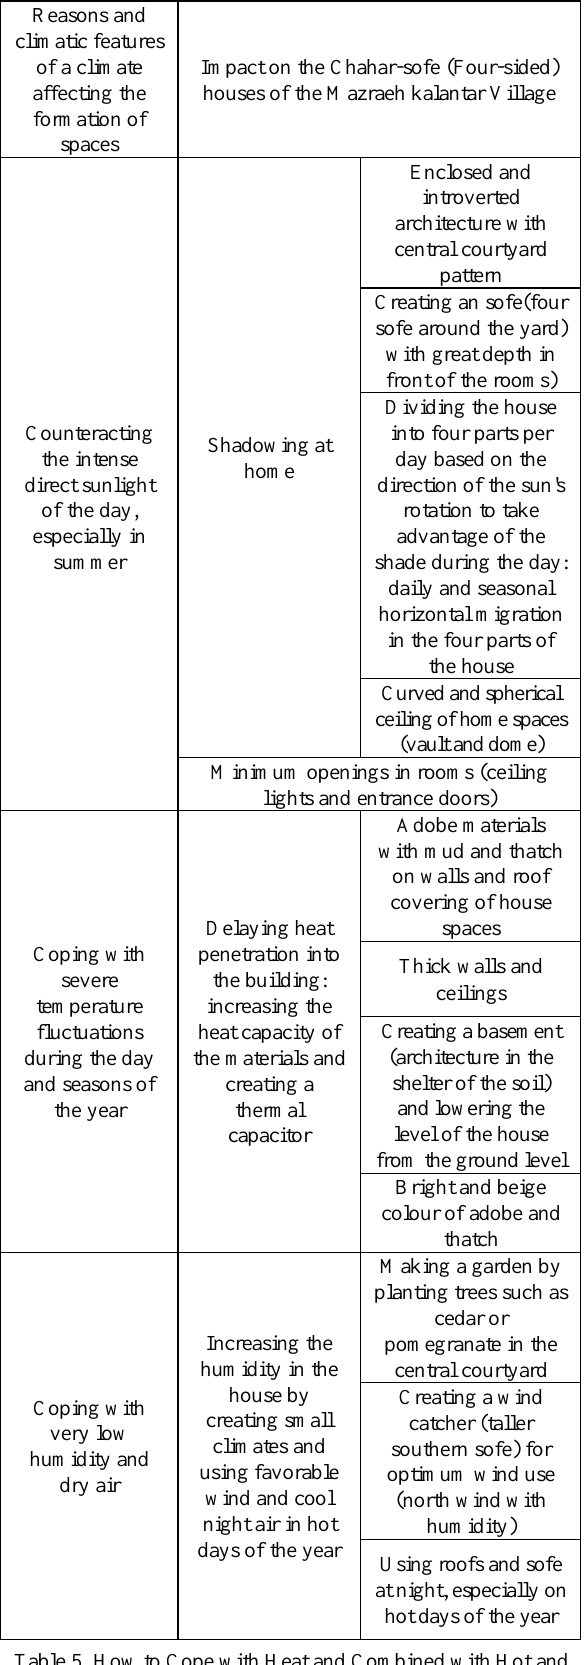
Table 5. How to Cope with Heat and Combined with Hot and Dry Climate in Chahar- Sofe Houses of the Zoroastrian Village of Mazrae